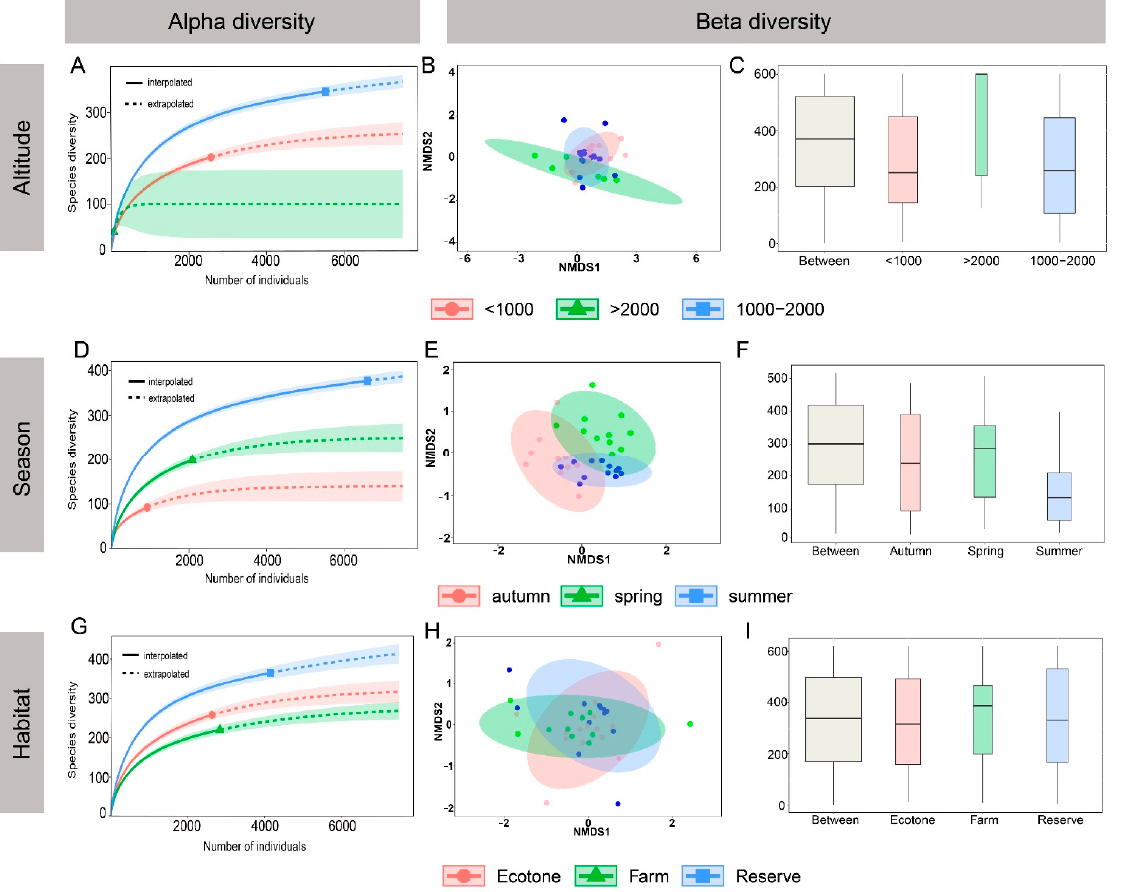
Figure 3. Butterfly diversity in the middle Qinling Mountains study sites. ( A , D , G ) Sample size-based rarefaction and extrapolation (dotted line segments) sampling curves for species richness (q = 0) for butterfly data from different altitudes, season and habitat types. ( B , E , H ) Nonmetric multidimensional scaling (NMDS) ordination of sites within different altitudes, seasons and habitat types based on taxonomic beta diversity. ( C , F , I ) Analysis of similarities (ANOSIM) in different altitude, season and habitat types. The border represents the interquartile range (IQR), the horizontal line represents the median value and the upper and lower tentacles represent 1.5 times the IQR range beyond the upper and lower quartile. “Between” represents differences between groups and the other three boxplots represent intra-group differences.